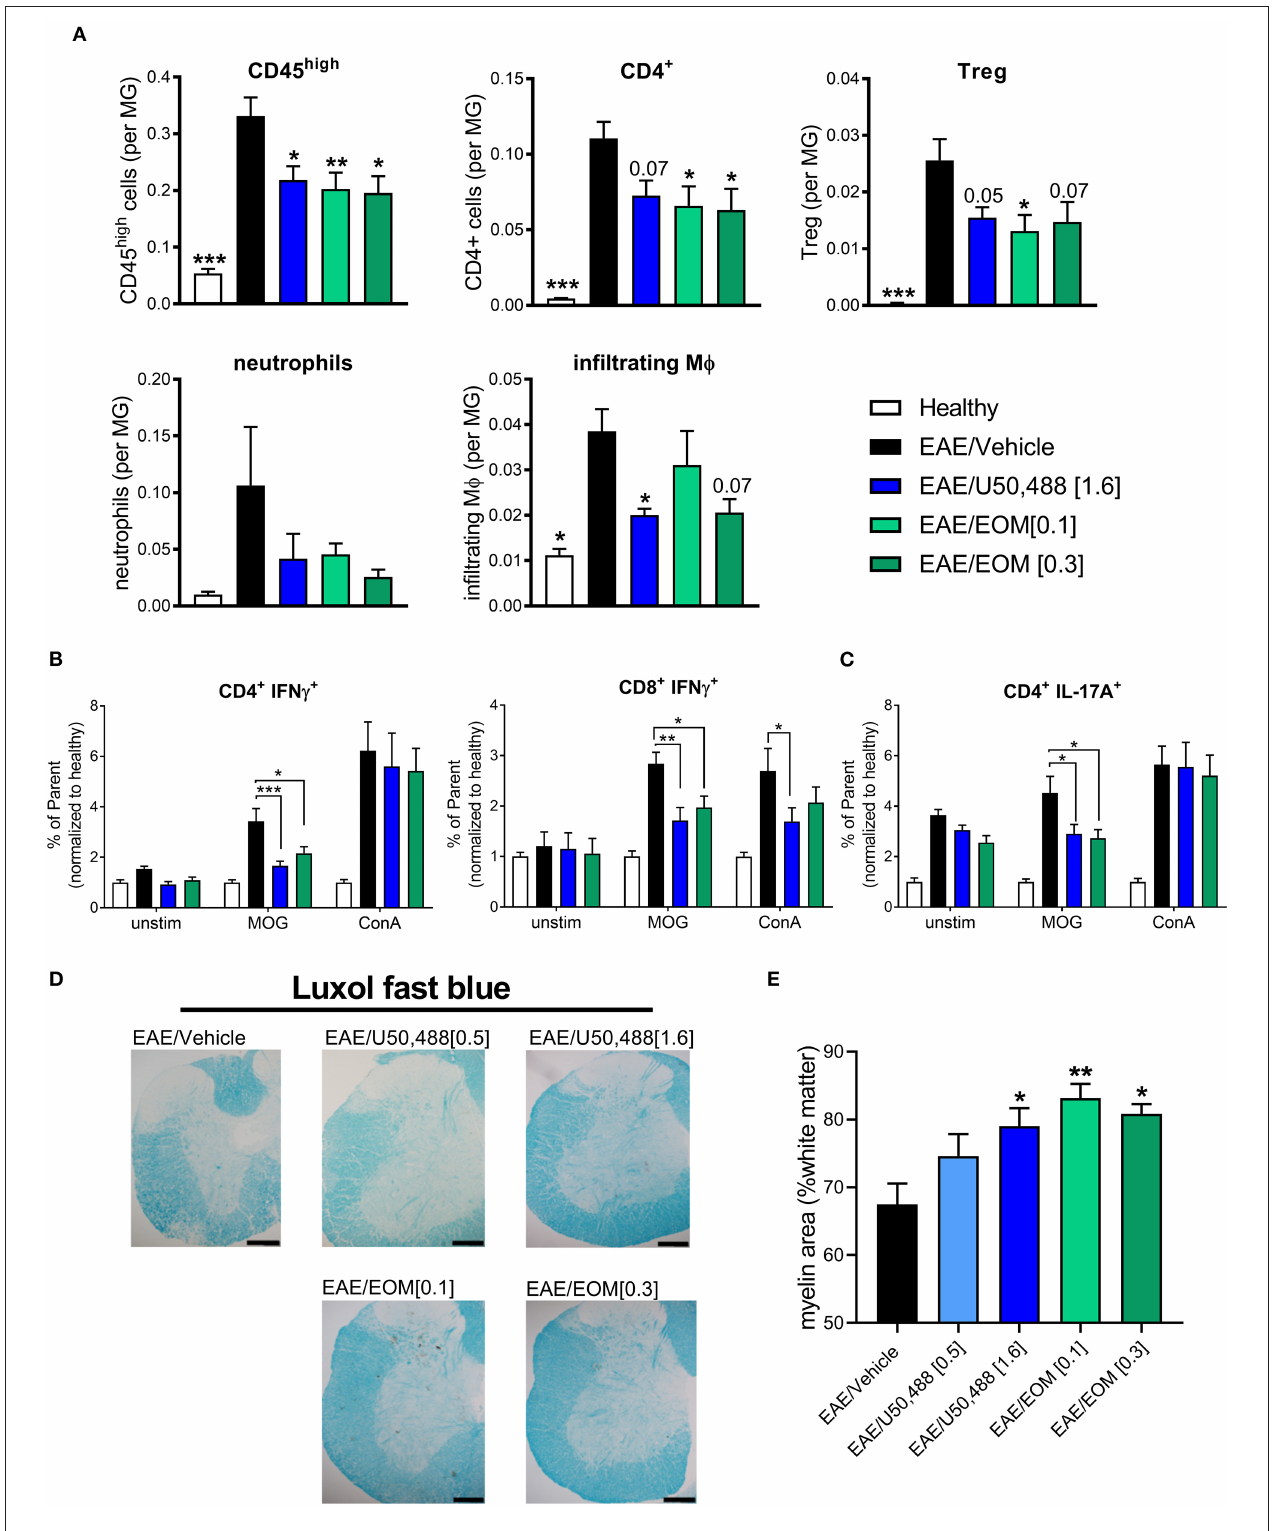
FIGURE 3 | The number of CNS-infiltrating immune cells were reduced by daily KOR agonist treatment. Analysis of lymphocyte populations from healthy, vehicle, EOM SalB (0.1 or 0.3 mg/kg) and U50,488 (1.6 mg/kg) treated brain tissue. All infiltrating immune cells were identified by CD45 high expression and the relative number of cells is expressed as a ratio to microglia. (A) Infiltrating cells identified by CD45 high expression, CD4 + T cells, CD4 + CD25 + regulatory T cells (Treg), neutrophils and